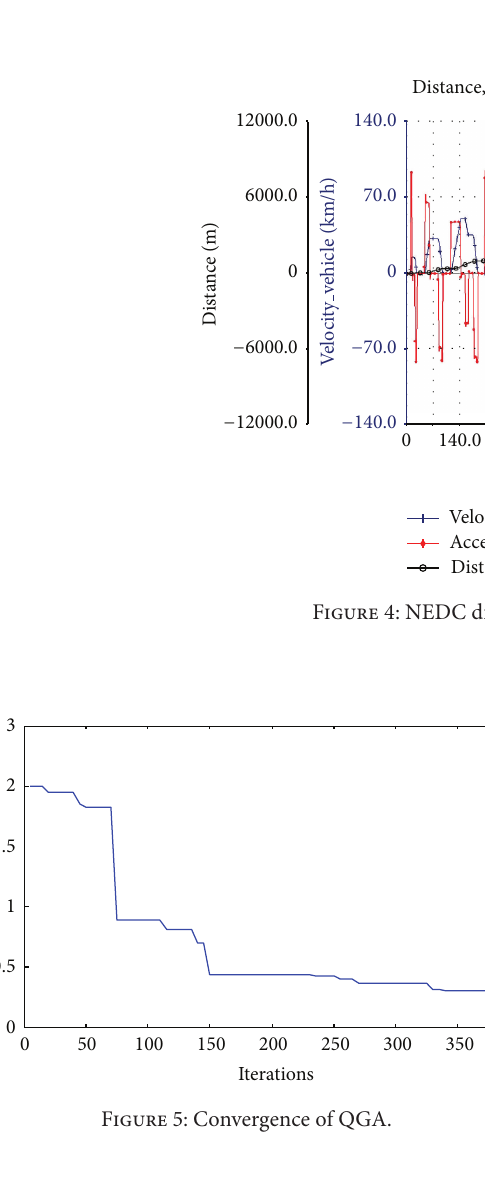
Figure 3: Data exchange Cruise-Simulinktm for Matlab API.